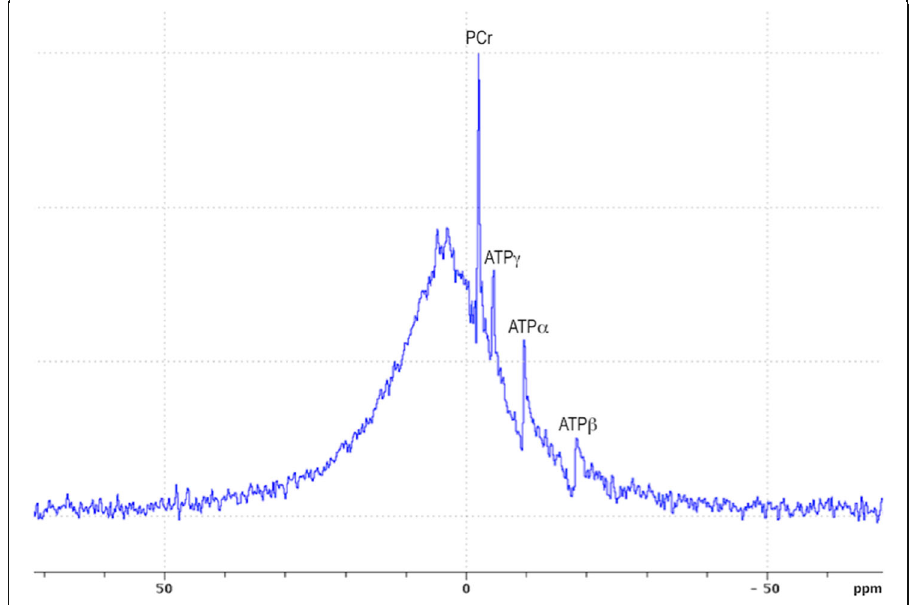
Fig. 1 31 P-NMR spectrum of a rat head in